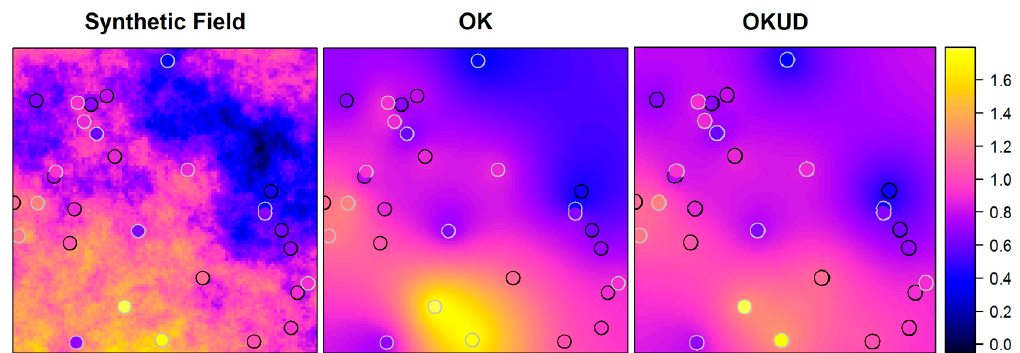
Figure 3. Example of a synthetic field generated during the third experiment. 15 accurate rain gauges (bordered in black) and 15 less accurate rain gauges (bordered in grey) are used to sample the field and the values are superimposed.